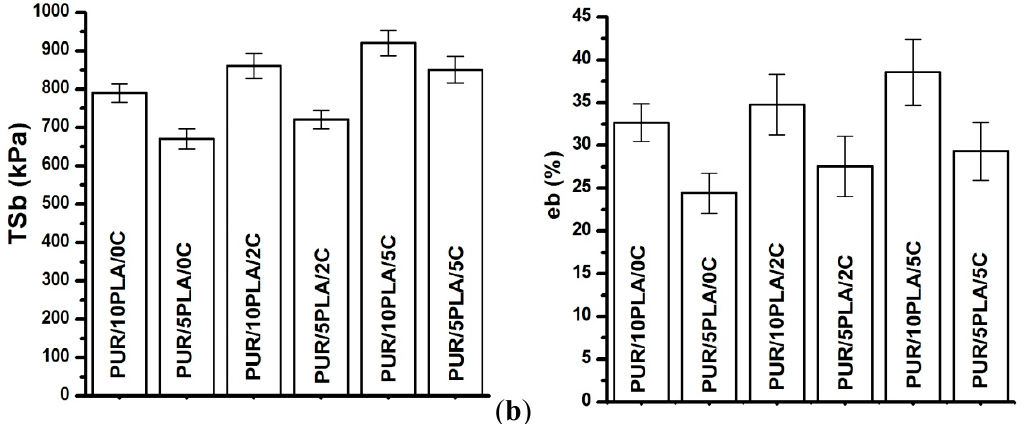
Figure 2. Tensile strength ( a ) and elongation at the break ( b ) of the unmodified and Cipro-modified HPPS.